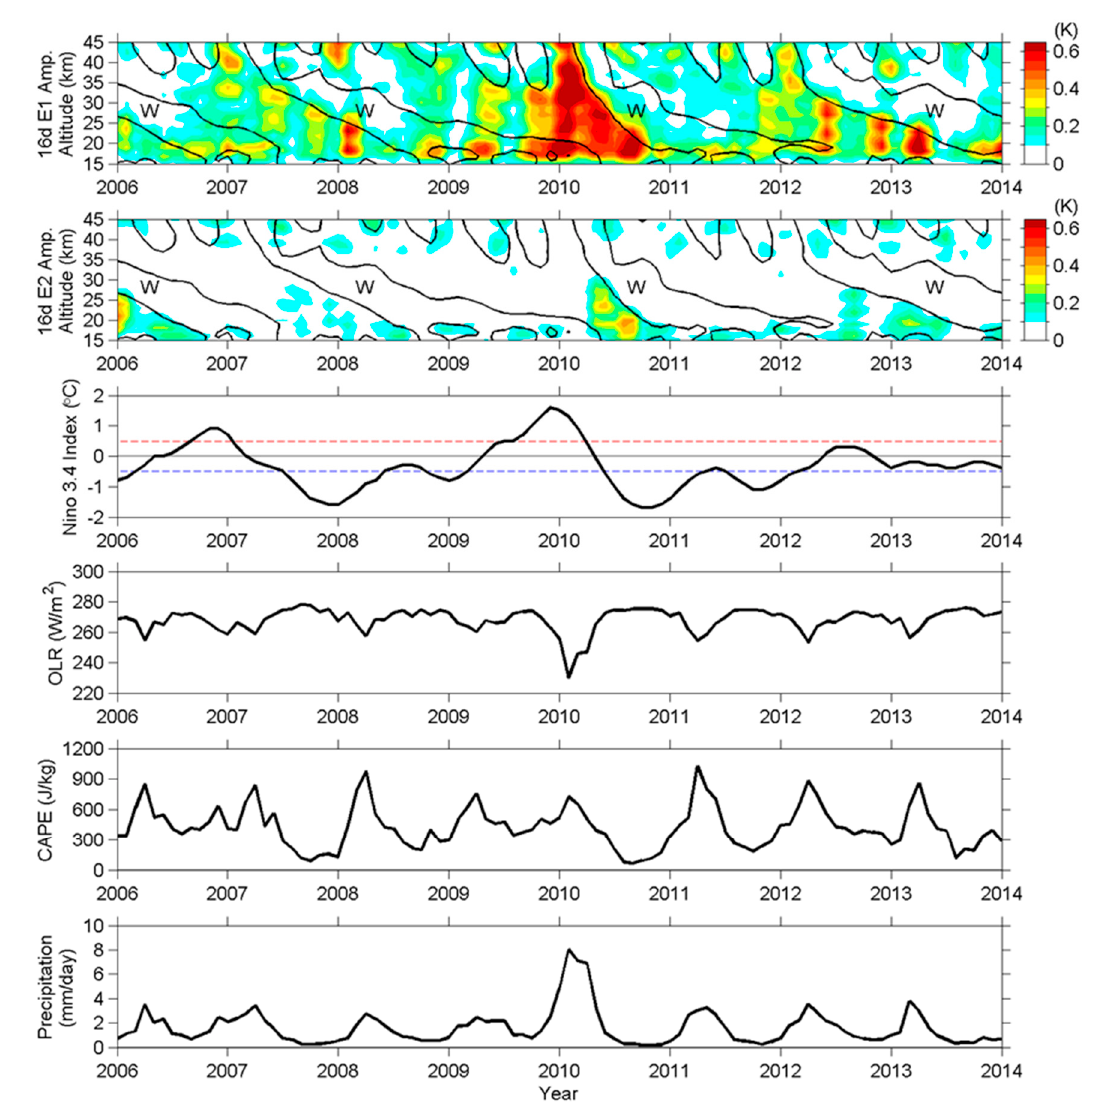
Figure 10. ( top two panels ) The amplitudes of the 16-day E1 and E2 waves as a function of time and altitude. The zero-wind contours are also plotted by black lines, and the westerly regimes are identified. ( bottom four panels ) The time series of the Niño 3.4 index, OLR, CAPE, and precipitation over the Niño 3.4 region (5°N–5°S, 120°–170°W). The dashed red line and blue line in the Niño 3.4 panel indicate the ±0.5°C criterions for El Niño and La Niña events, respectively.